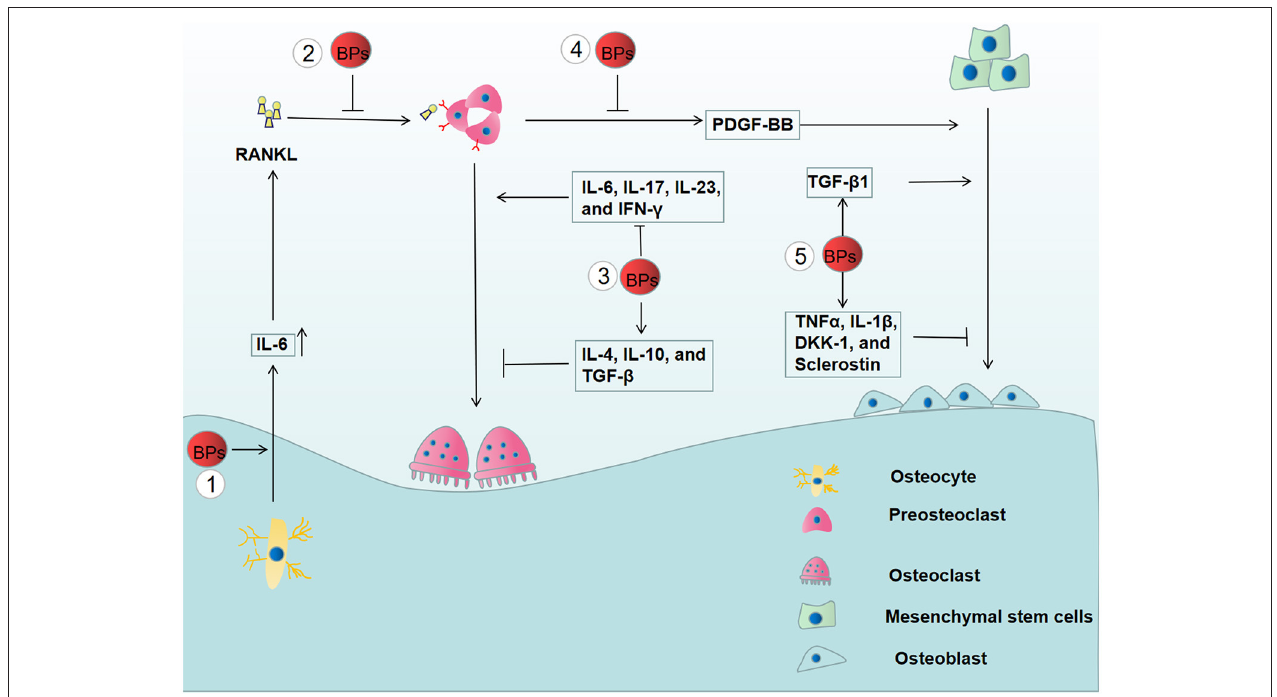
FIGURE 3 | The effects of BPs on bone remodeling. (1) The increased secretion of IL-6 from BPs-treated osteocyte enhances the expression of RANKL, thereby, promoting the osteoclast differentiation. (2) However, BPs inhibit osteoclast differentiation by suppressing the RANKL/OPG/RANK signaling pathway. (3) BPs have an inhibitory effect on the osteoclast differentiation by suppressing the osteoclastogenic cytokines (IL-6, IL-17, IL-23, and IFN- γ ) and increasing anti-osteoclastogenic cytokines (IL-4, IL-10, and TGF- β ). (4) Osteogenic differentiation is inhibited by the reduced release of PDGF-BB from preosteoclasts. (5) Moreover, BPs affect osteoblastogenesis by altering the release of the pro-inflammatory mediators, including TNF α , IL-1 β , DKK-1, sclerostin, and TGF- β